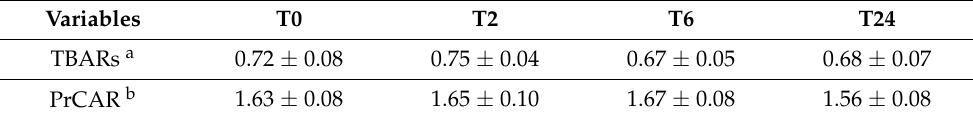
Table 4. Plasma thiobarbituric acid reactive substances and protein carbonyl levels.